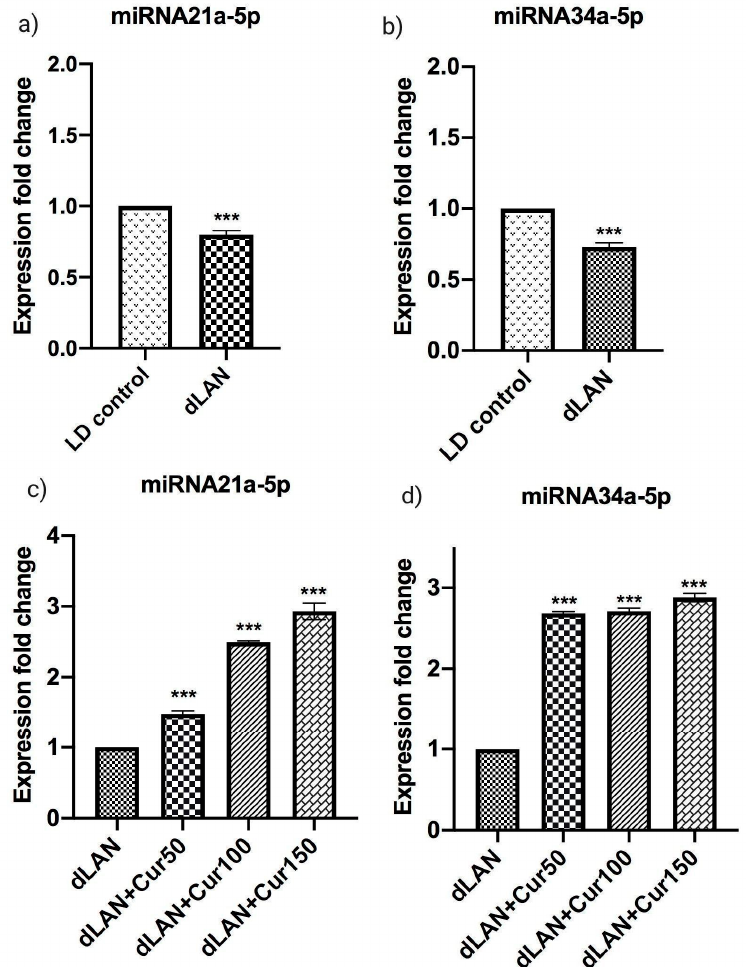
Figure 6. E ff ect of Curcumin on dLAN altered hippocampal miRNA ( a , c ) miRNA21a-5p, and ( b , d ) miRNA34a-5p. Values are represented as mean ± standard deviation. The t- test was employed to compare the results between LD and dLAN groups ( a , b ). Two-way ANOVA test was employed to compare the results between dLAN exposed vs. dLAN treated groups ( c , d ). All the data collected was analysed using GraphPad Prism-8 software. The values of *** p < 0.001 represents a statistically significant difference between the groups.